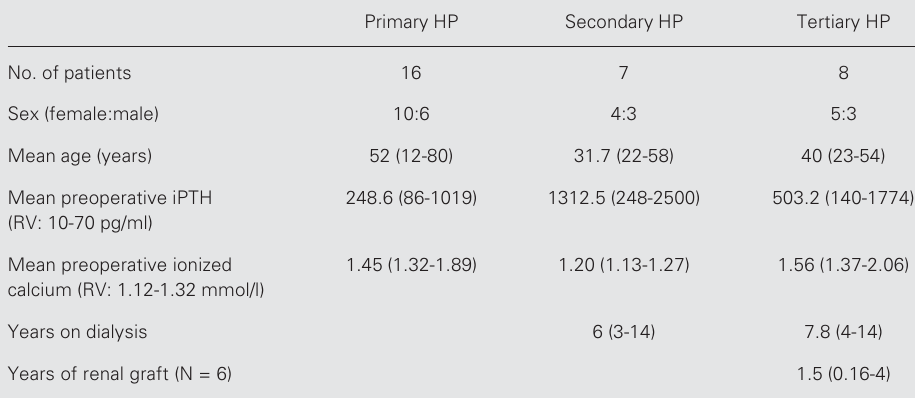
Table 1. Characteristics of patients and preoperative laboratory